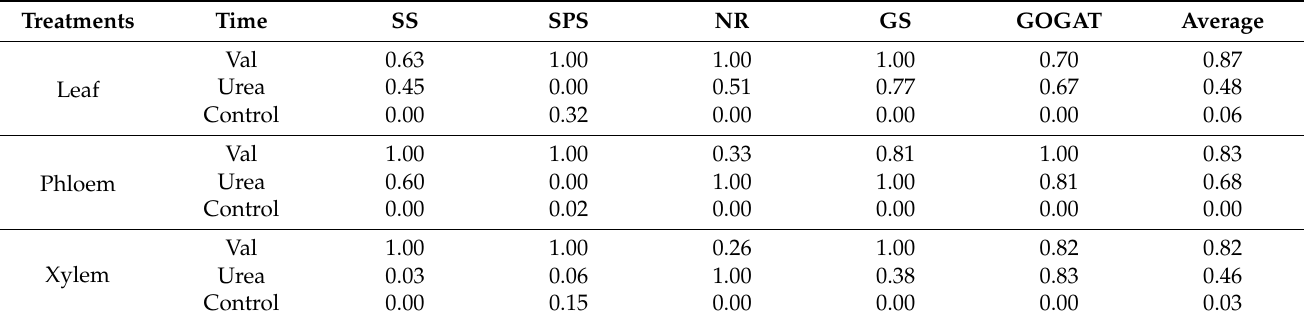
Table 2. Comprehensive effects of the different treatments on key enzymes of carbon and nitrogen metabolism.